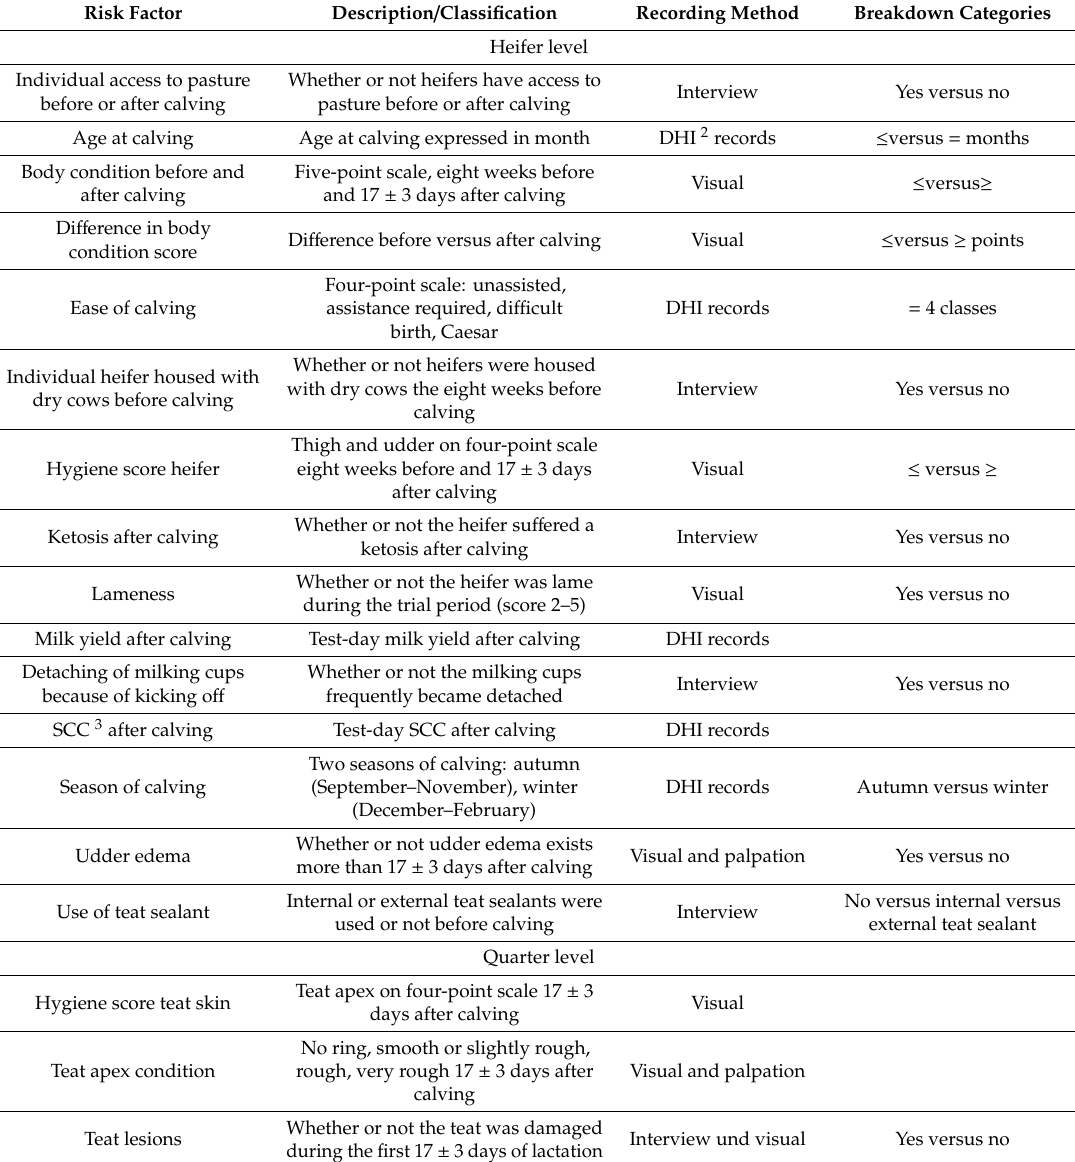
Table 1. Overview of heifer und quarter level risk factors potentially related to IMI 1 in